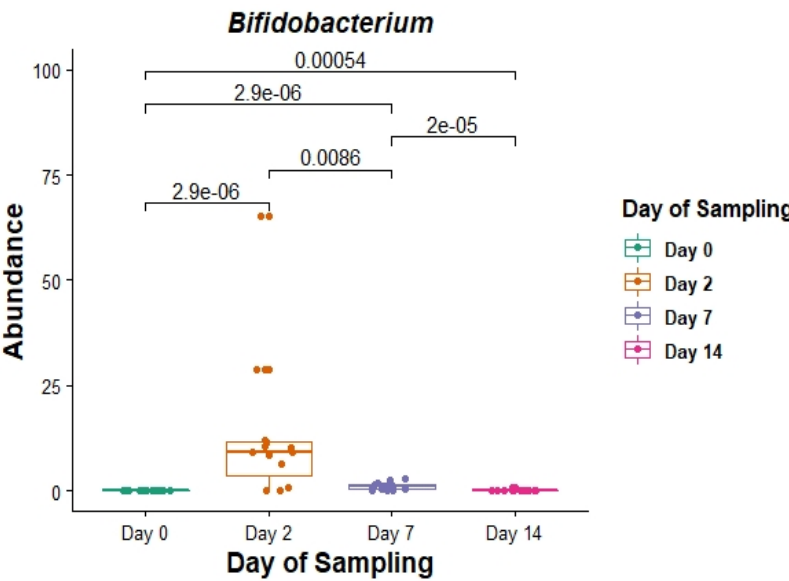
Figure 4. The relative abundance (in%) of the genus Bifidobacterium in faecal DNA either on the day of induction (day 0) or 2, 7 and 14 days post induction (days 2, 7 and 14).